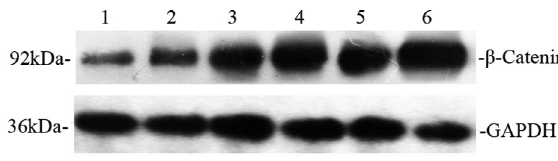
Figure 1. Expression of b -catenin was significantly higher in the fetus group ( lanes 4,5,6 ) than in the control group ( lanes 1,2,3 ) by Western